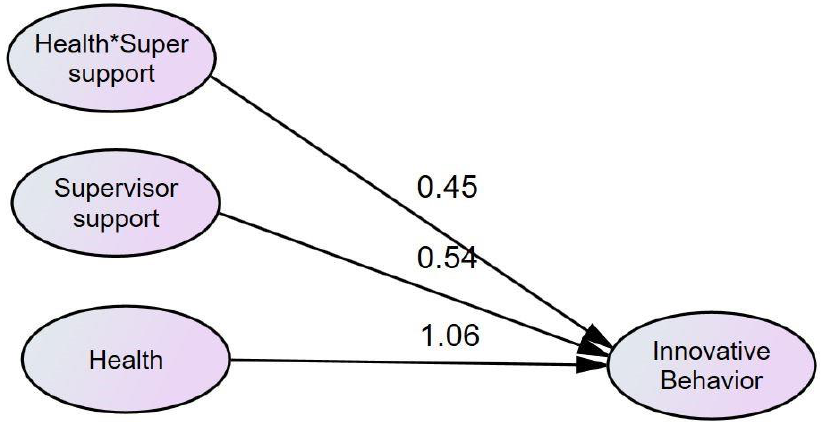
Figure 5. Moderation analysis of supervisor support with health and innovative work behavior.